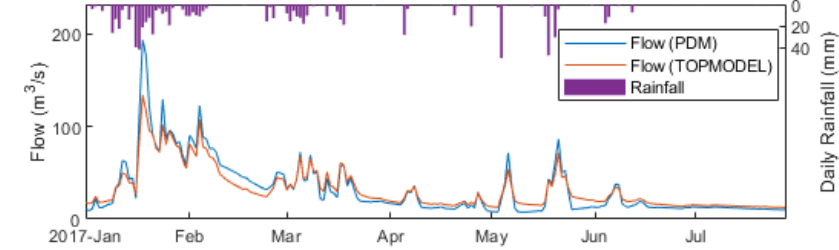
Figure 4. Daily modeled flow in the lower basin using PDM and TOPMODEL.